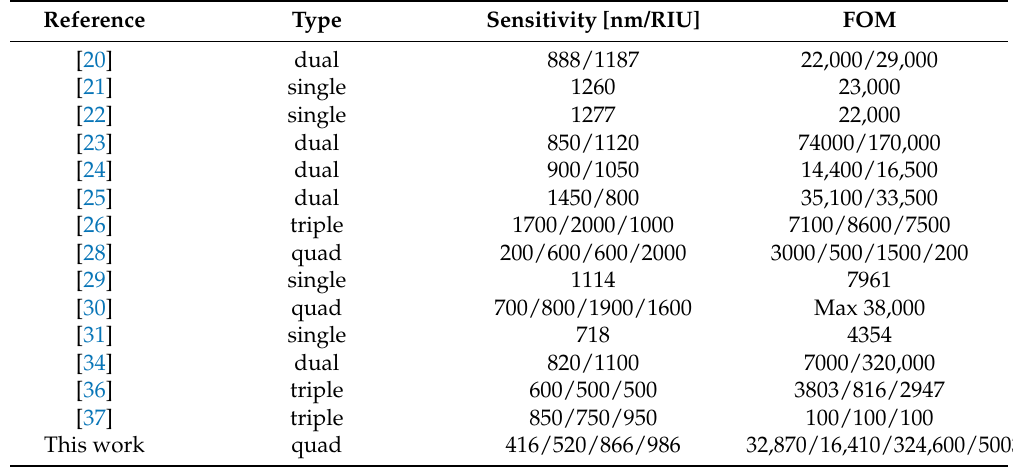
Table 1. Comparison of the proposed sensor and other recently published similar solutions.